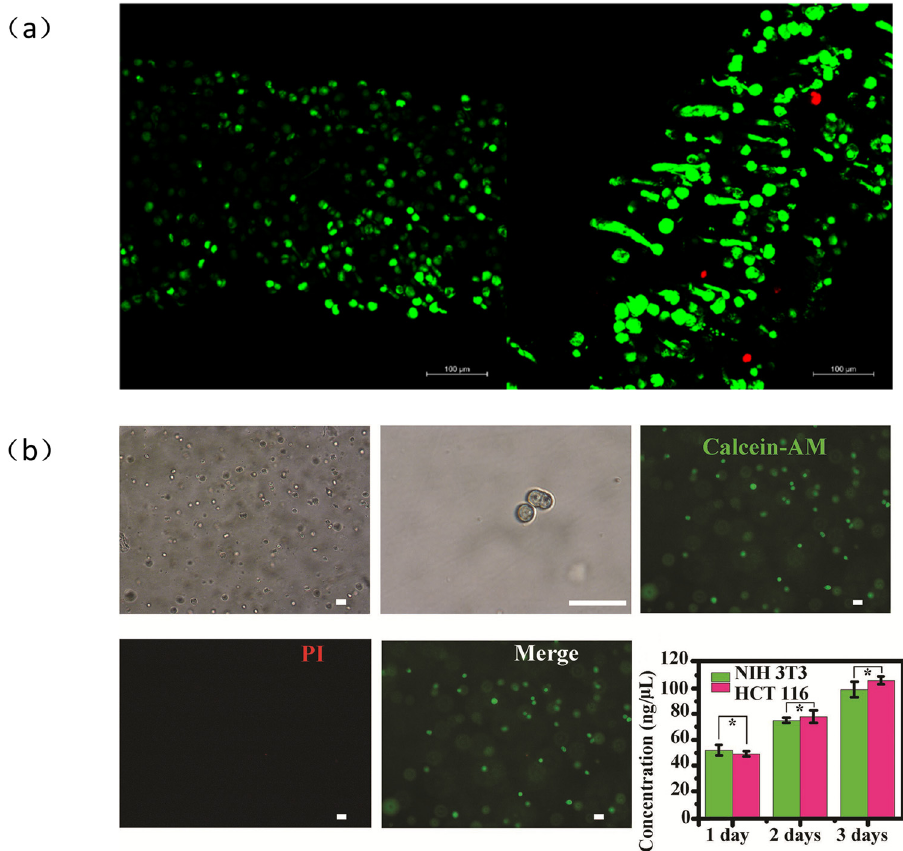
Figure 16: ( a ) Microscopic observation of cell viability after 1 and 7 days of cultured cells in alginate hydrogel containing living cells. Reproduced from ref. [ 173 ] with permission from Mary Ann Liebert Inc. ( b ) Cell growth and survival in bioink. Reproduced from ref. [ 174 ] with permission from Wiley - VCH